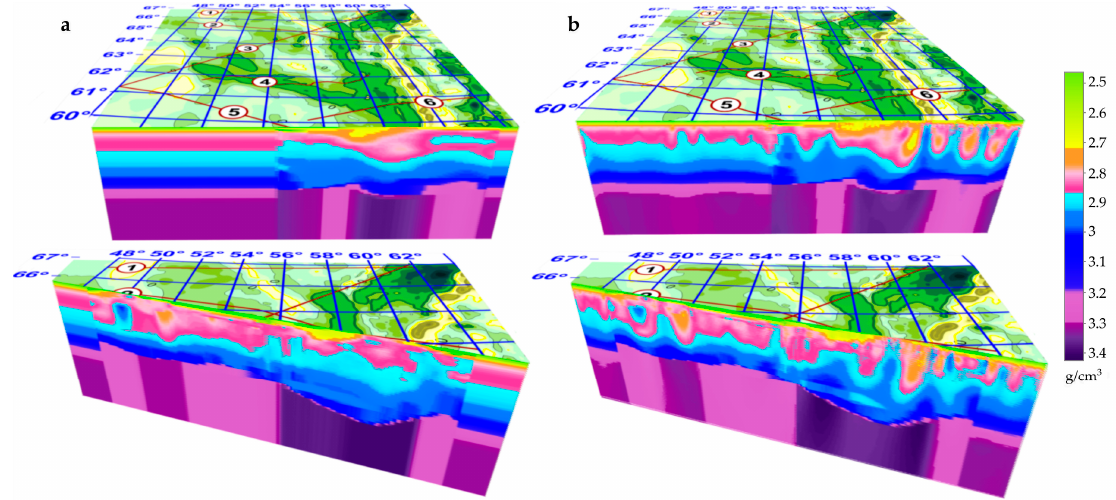
Figure 10. DSS profile scheme with a map of a gravity field anomaly in the Bouguer reduction. Profiles: (1) Agat-2, (2) Quartz, (3) Globus, (4) Syktyvkarskii, (5) Rubin-1, and (6) Krasnoleninskiy.